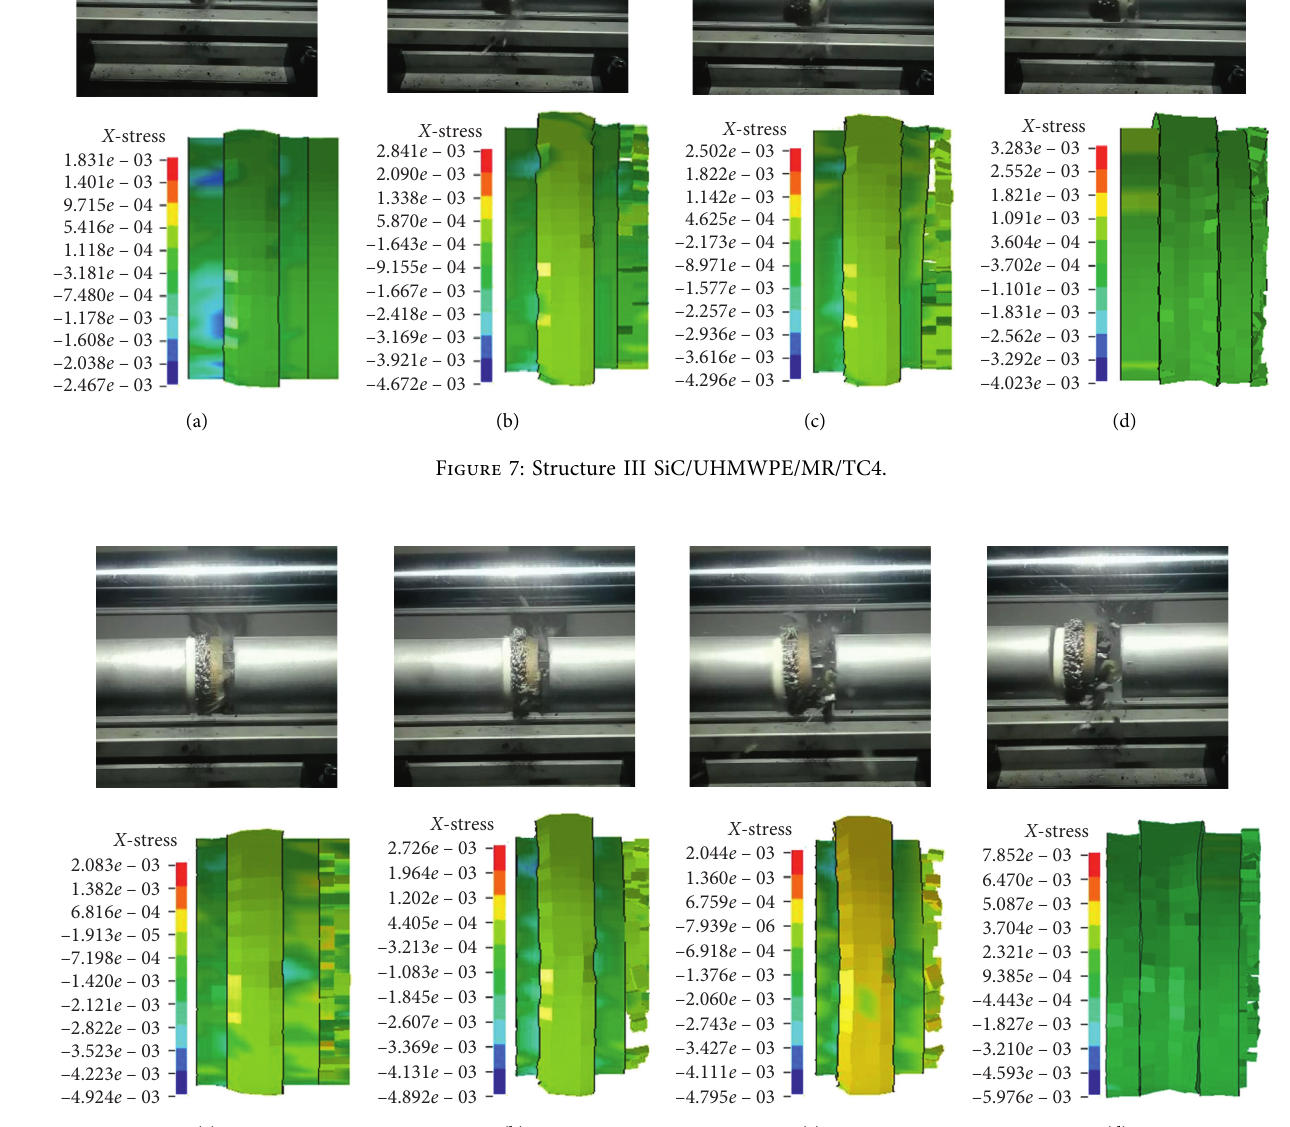
Figure 8: Structure IV